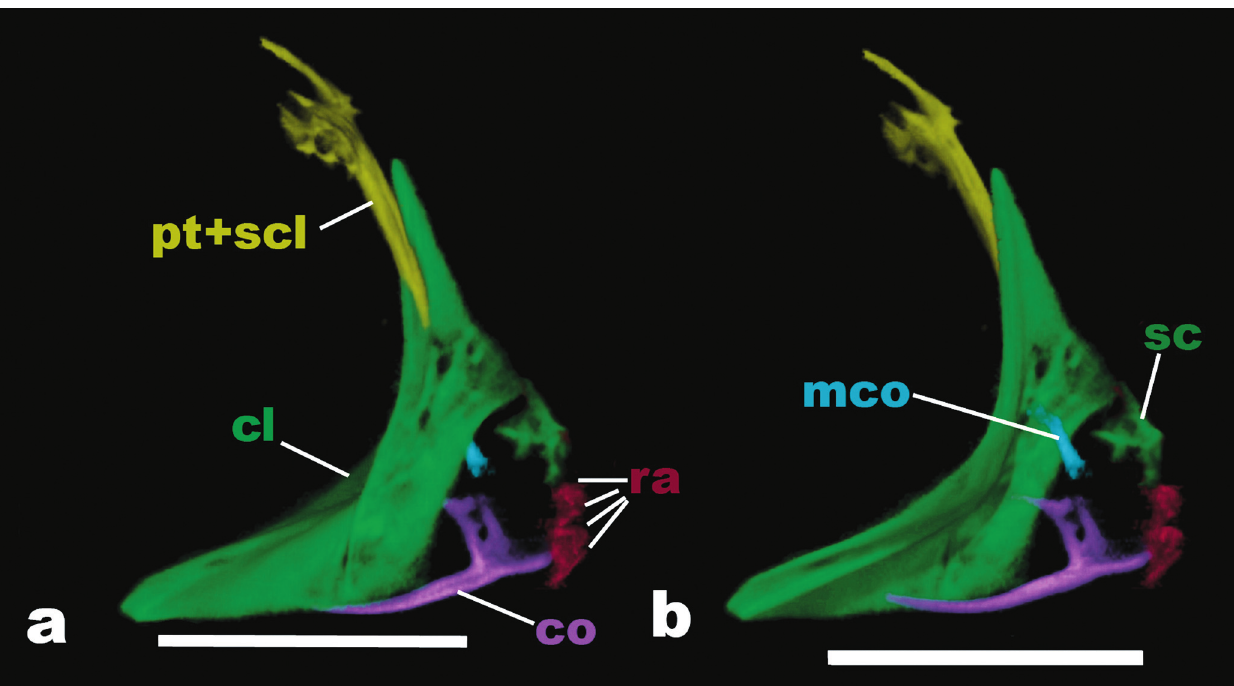
Fig. 9. Pectoral girdle of left side of Iracema caiana (MZUSP 49205, 235 mm SL; pectoral fin rays digitally removed). ( a ) Lateral view; ( b ) Midsagittal view. Anterior to left. Scale bar is 5 mm. Abbreviations: pt+scl = posttemporal + supracleithrum; cl = cleithrum; co = coracoid; sc = scapula; mco = mesocoracoid; and ra =